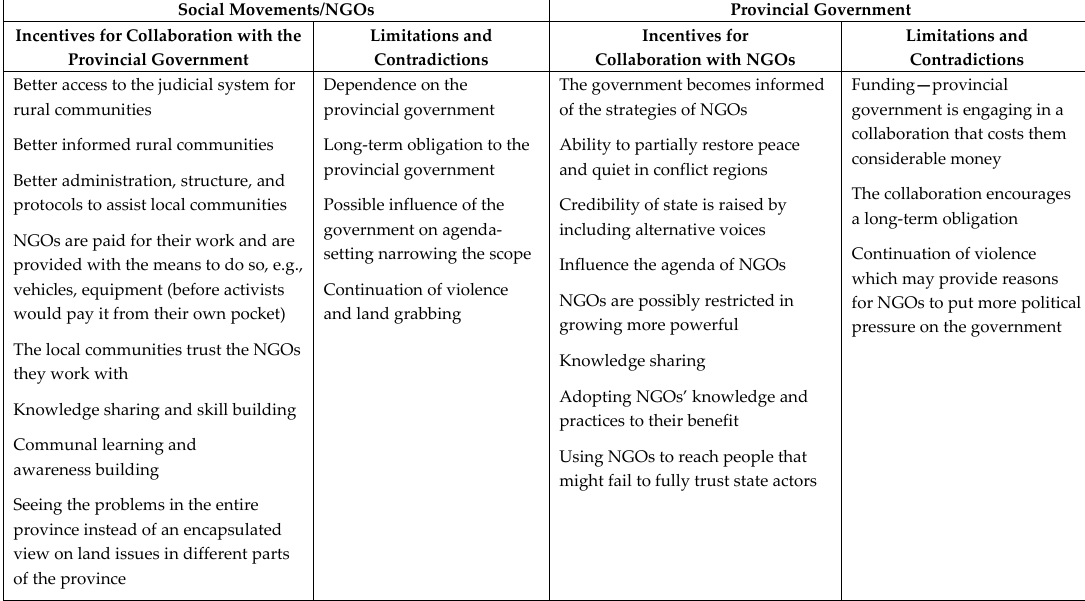
Table 1. Overview of the incentives for, limitations to, and contradictions inherent in collaboration. NGOs: Non-government organizations. Social Movements/NGOs Provincial